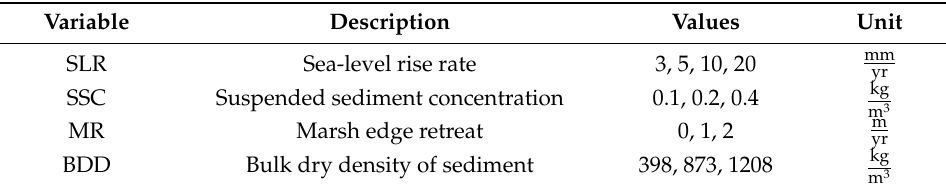
Table 2. The parameters a ff ecting the marsh and dike varied in this study. Variable